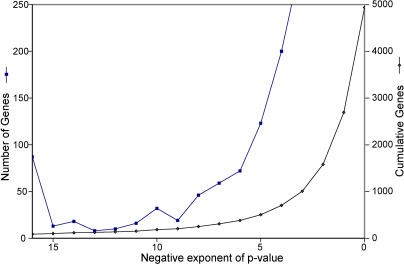
Distribution of p-Values for Cell Cycle–Regulated GenesThe x-axis shows bins of p-values of the significance of cell cycle regulation. From the left, the bins are as follows: (1) Genes with p-values less than 10−16 (87 genes); (2) Genes with p-values between 10−15 and 10−16 (13 genes); (3) Genes with p-values between 10−14 and 10−15 (13 genes); (4) Genes with p-values between 10−13 and 10−14 (eight genes); etc. The number of genes in each bin is shown on the left y-axis (dark blue squares). Also shown (right y-axis, magenta diamonds) is the cumulative number of genes at each p-value or lower. Thus there are about 1,000 genes with a p-value of 10−3 or less.